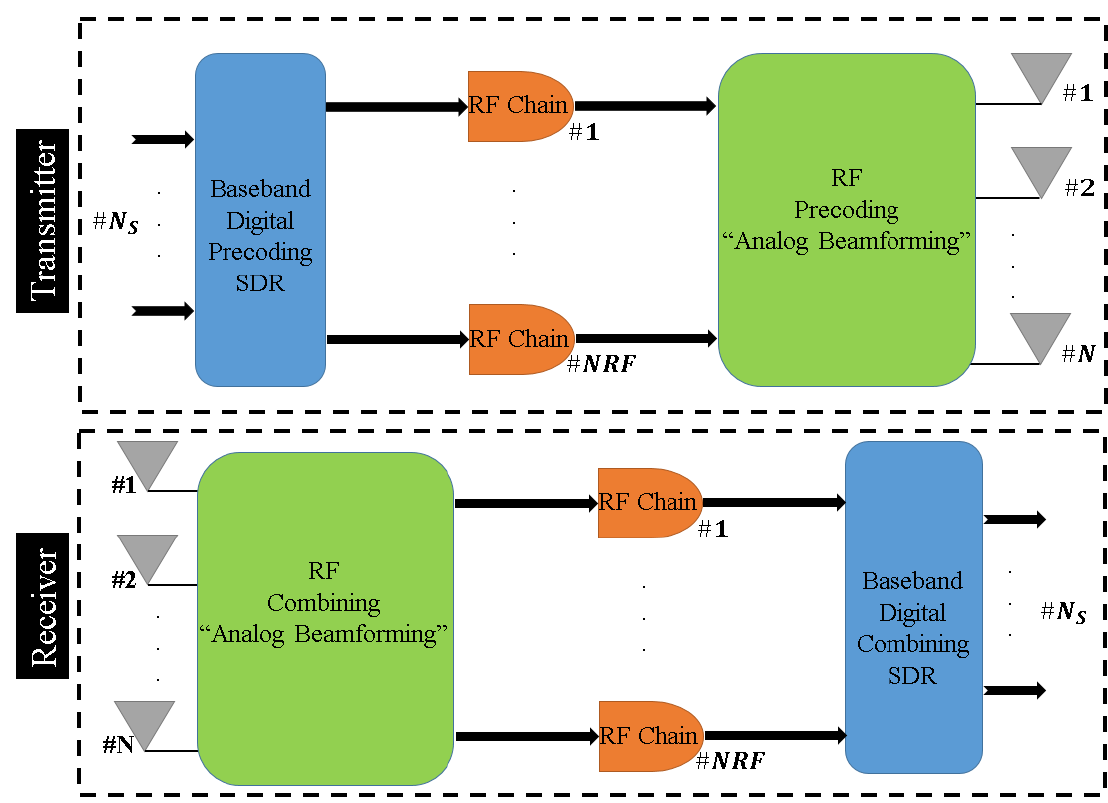
Figure 2. Hybrid beamforming